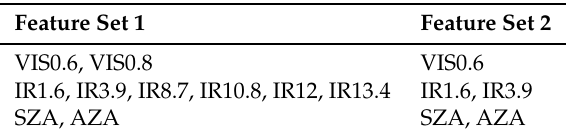
Table 1. Two sets of input features used in the GBRT